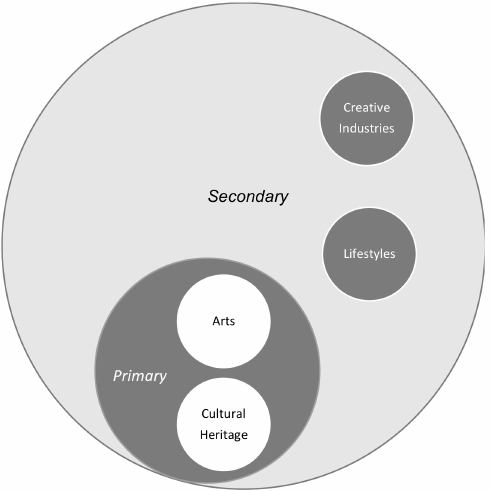
Figure 1. The inner circle and the outer circle of cultural tourism. Source: own elaboration, based on EENCA [30] (p.